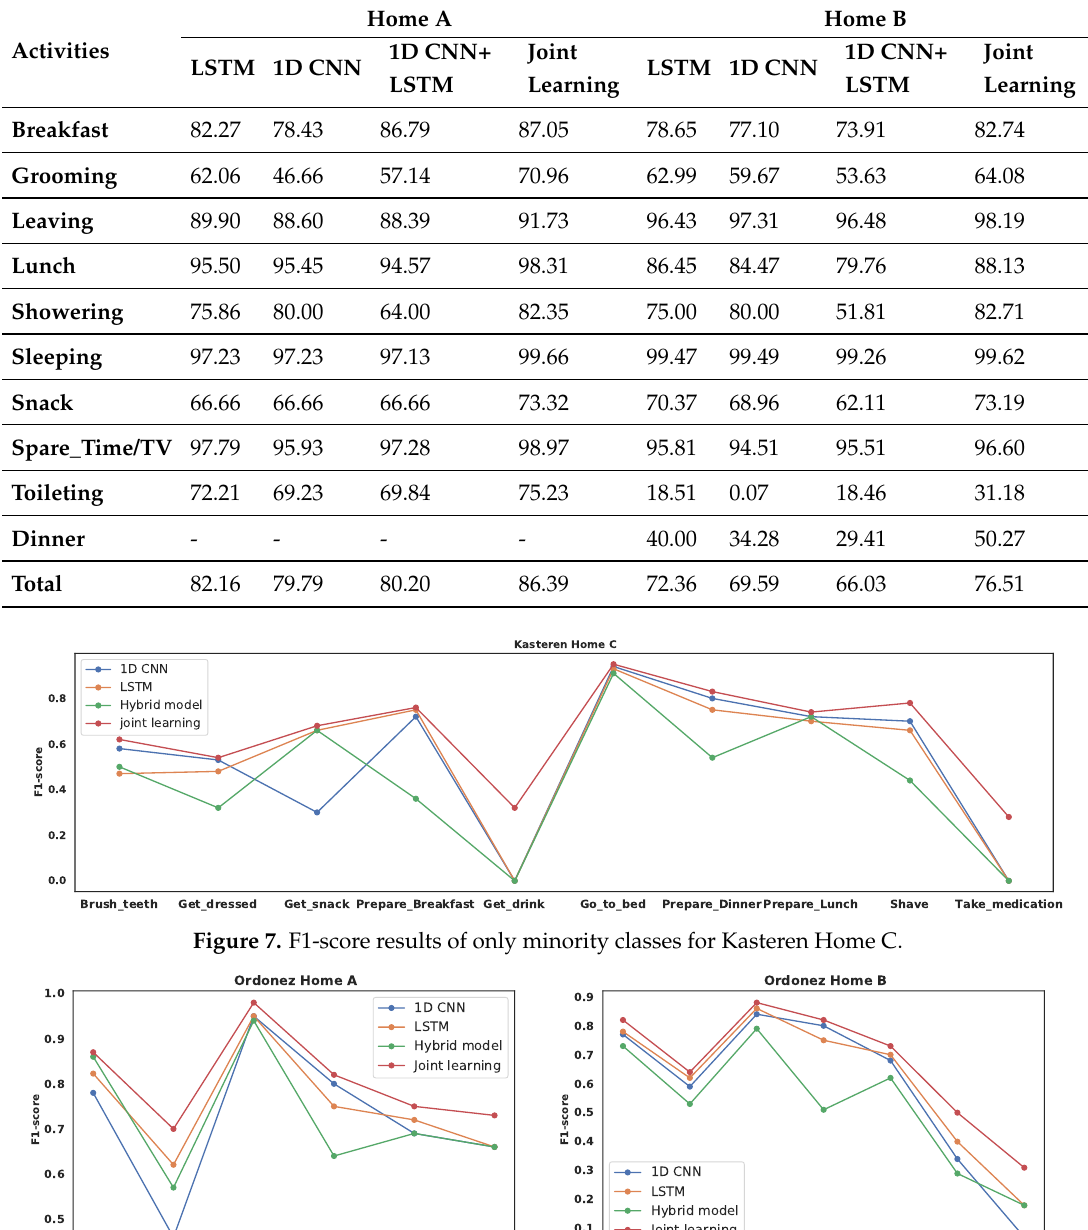
Table 4. F1-score results of Ordonez Smart home datasets.